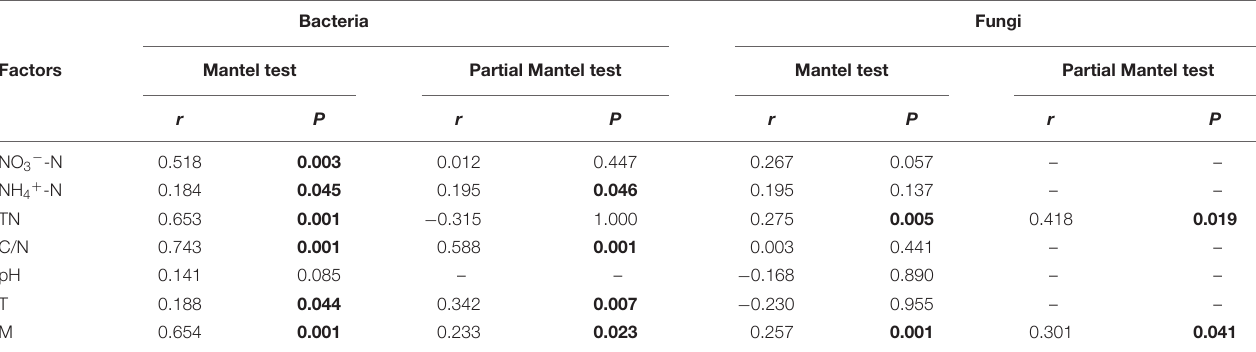
Values in bold indicate significant correlations (P < 0.05). TN, total nitrogen; C/N, the ratio of TC to TN; T, temperature; M, Moisture